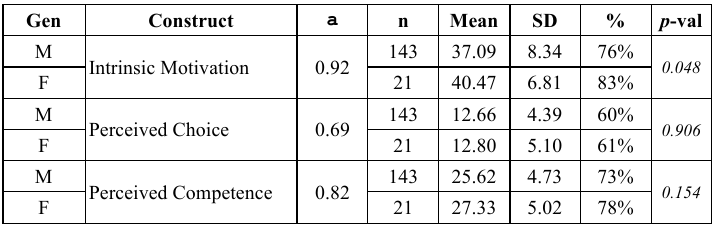
TABLE 1. Results from Pre-survey of students - Gender